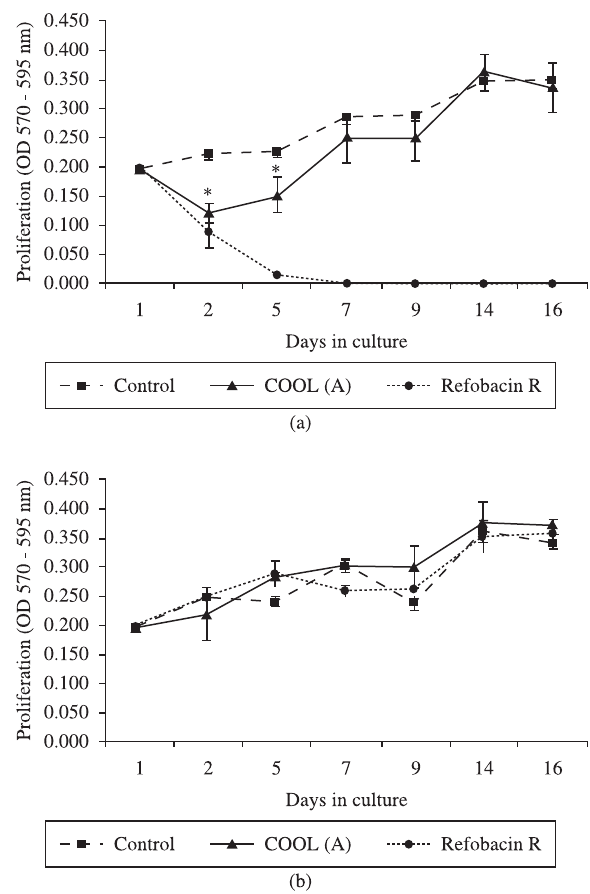
Figure 7. ALP activity in pHOB cell cultures derived from donor 1 incubated with specimens of COOL formulation A or reference material at day 16, cal- culated as percentage of the control. Cement specimens were added to the cell cultures directly after preparation (0 hour) and after setting for 5 or 24 hours. Results are the mean ± SD (n = 3). Significant differences between the groups are marked with * (P < 0.05) or ** (P <